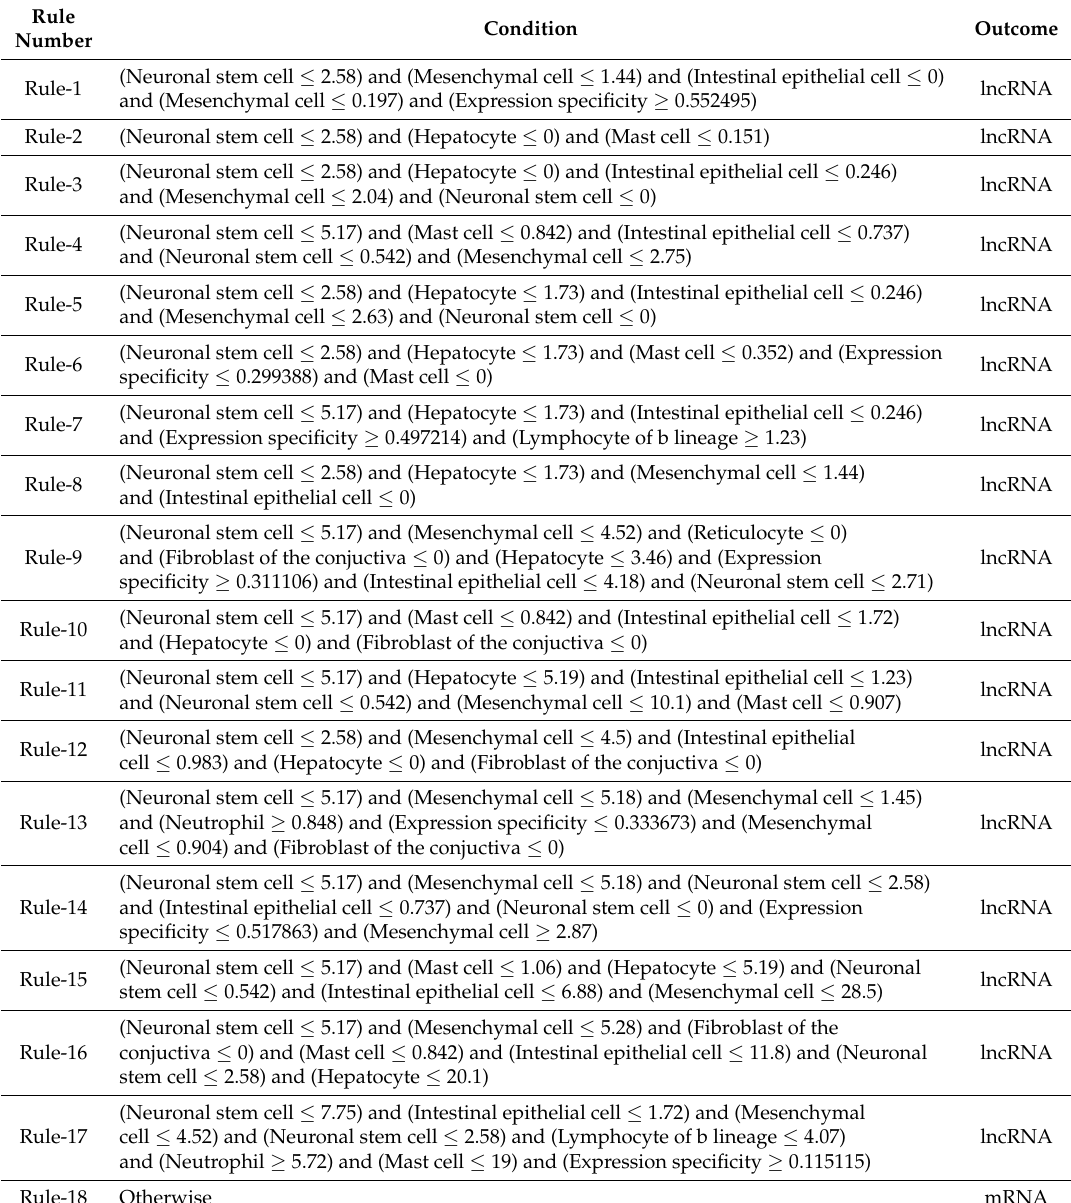
Table 3. 18 Classification rules yielded by repeated incremental pruning to produce error reduction (RIPPER) on top ten